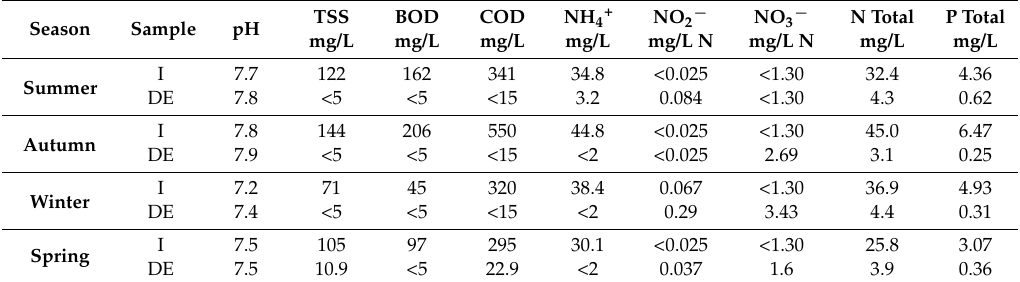
Table 1. Physicochemical characteristics of the raw sewage (I) and disinfected effluent (DE).